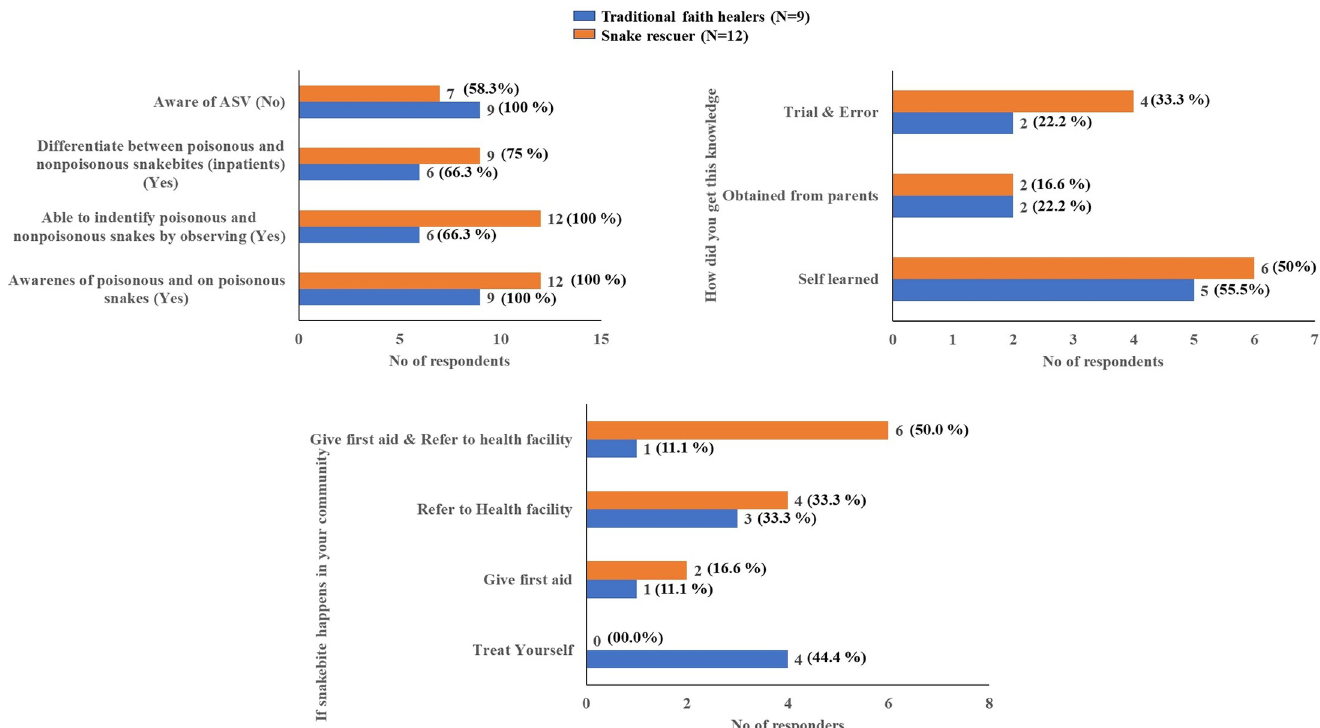
Fig 4. Awareness, knowledge of snakebite and treatment practices amongst the traditional faith healers and snake rescuers.